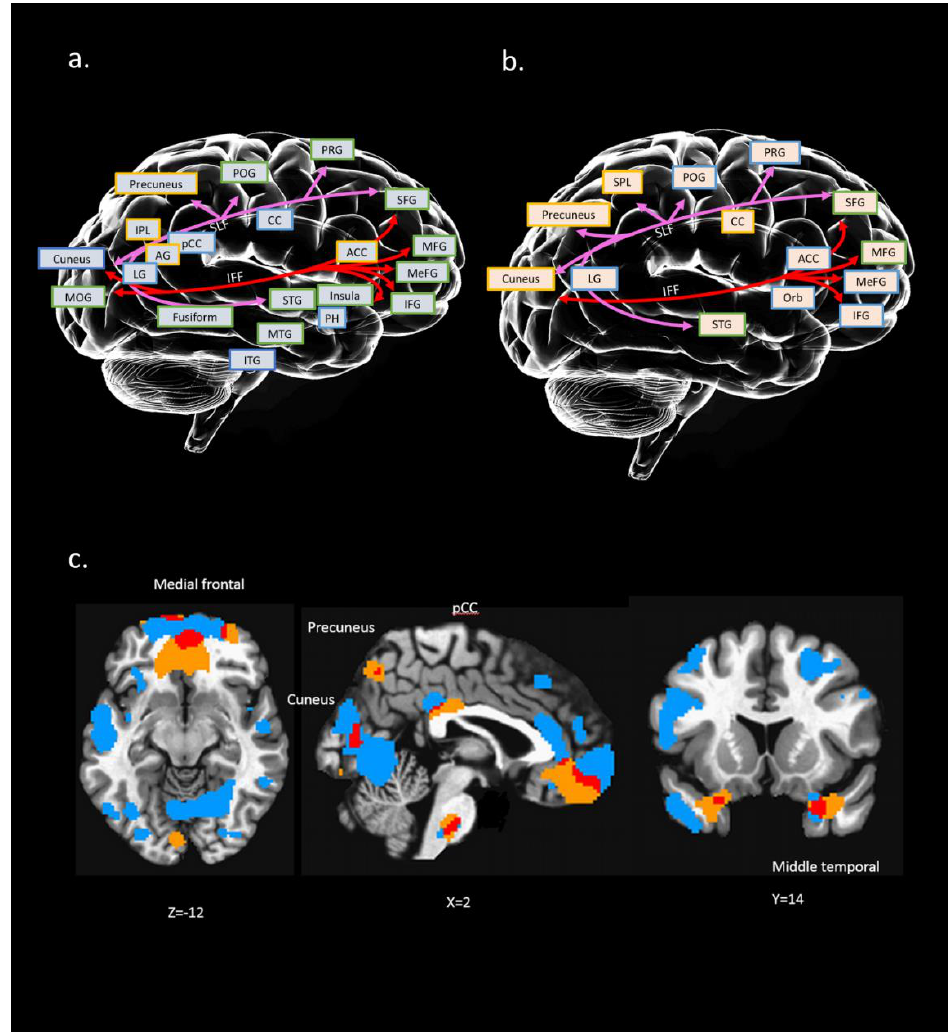
Figure 2. Conceptual illustration to present possible relation between brain regions (structural and functional) and connection paths [white matter (WM) tracts]: ( a ) interaction between WM tracts and GM region of IC#23; ( b ) interaction between WM tracts and ALFF regions of IC#23. A colored square with a yellow edge indicates positive clusters in this region. A colored square with a blue edge indicates negative clusters in this region. Colored square with green edge indicates both positive and negative clusters in this region; ( c ) overlapping (marked in red) between IC #23’s GM (marked in blue) and ALFF regions (marked in yellow); x, y, z = 2, 14, − 12. Distinct WM tracts were marked with different colors. PRG: precentral gyrus; POG: postcentral gyrus; MFG: middle frontal gyrus; MeFG: medial frontal gyrus; IFG: inferior frontal gyrus; CC: cingulate cortex; ACC: anterior cingulate; pCC: posterior cingulate cortex; PH: parahippocampal gyrus; STG: superior temporal gyrus; MTG: middle temporal gyrus; ITG: inferior temporal gyrus; IPL: inferior parietal gyrus; LG: lingual gyrus; MOG: middle occipital gyrus; Orb: orbital gyrus; AG: angular